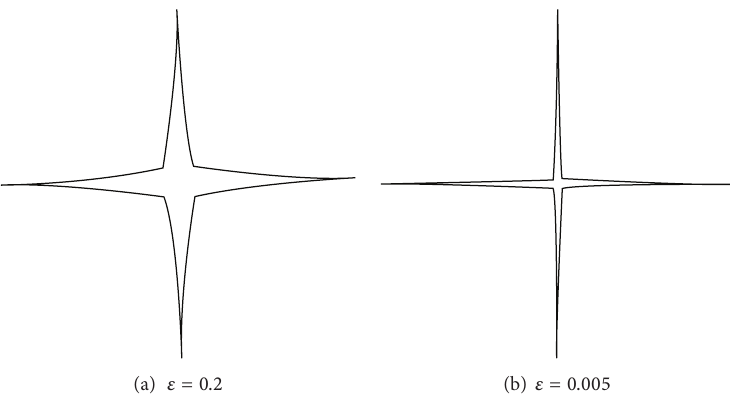
Figure 8: Star-shaped throat at different aspect ratios.